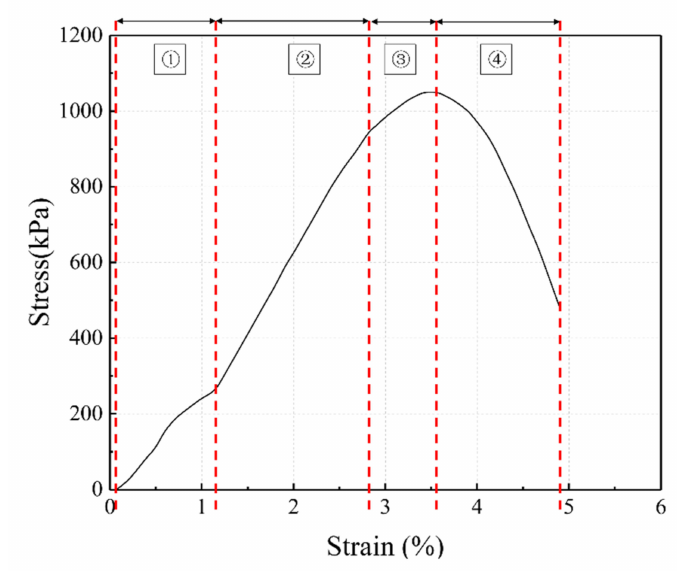
Figure 9. Schematic diagram of typical stress–strain